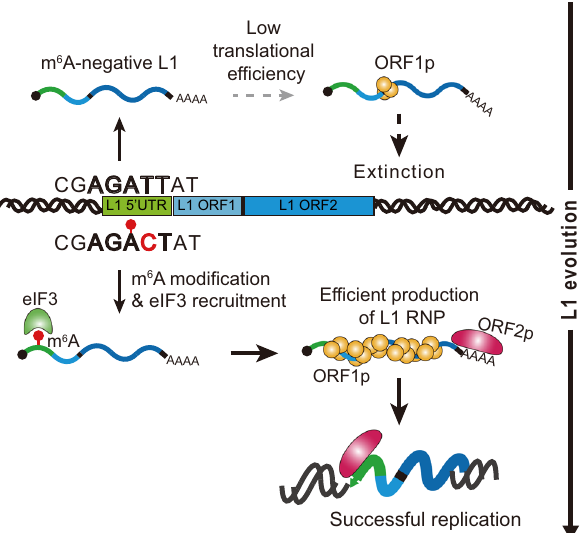
Fig. 7 A proposed model for the role of m 6 A in L1 replication and evolution. Full-length young L1s RNA have m 6 A in 5 ′ UTR A332 residue (lower part of scheme, m 6 A in red circle and m 6 A-gain mutation at T333C in red). 5 ′ UTR m 6 A cluster recruits eIF3 complex (green) and promotes translation of L1 ORF1p (yellow). Increased L1 ORF1p synthesis leads ef fi cient production of L1 ribonucleotide particle (RNP) formation with its parental mRNA (line with poly A) and the reverse transcriptase, L1 ORF2p (magenta). The L1 RNP enters the nucleus and then generate the progeny through insertion of its cDNA. Old L1s with no A332 m 6 A motif have lower ef fi ciency of translation and replication than those of A332 m 6 A-positive L1s (upper part of scheme). Since the A332 m 6 A motif fi rst appeared ~12 million years ago, m 6 A-stimulated L1 replication has allowed m 6 A-positive L1s to survive during evolution, but made old L1s out of